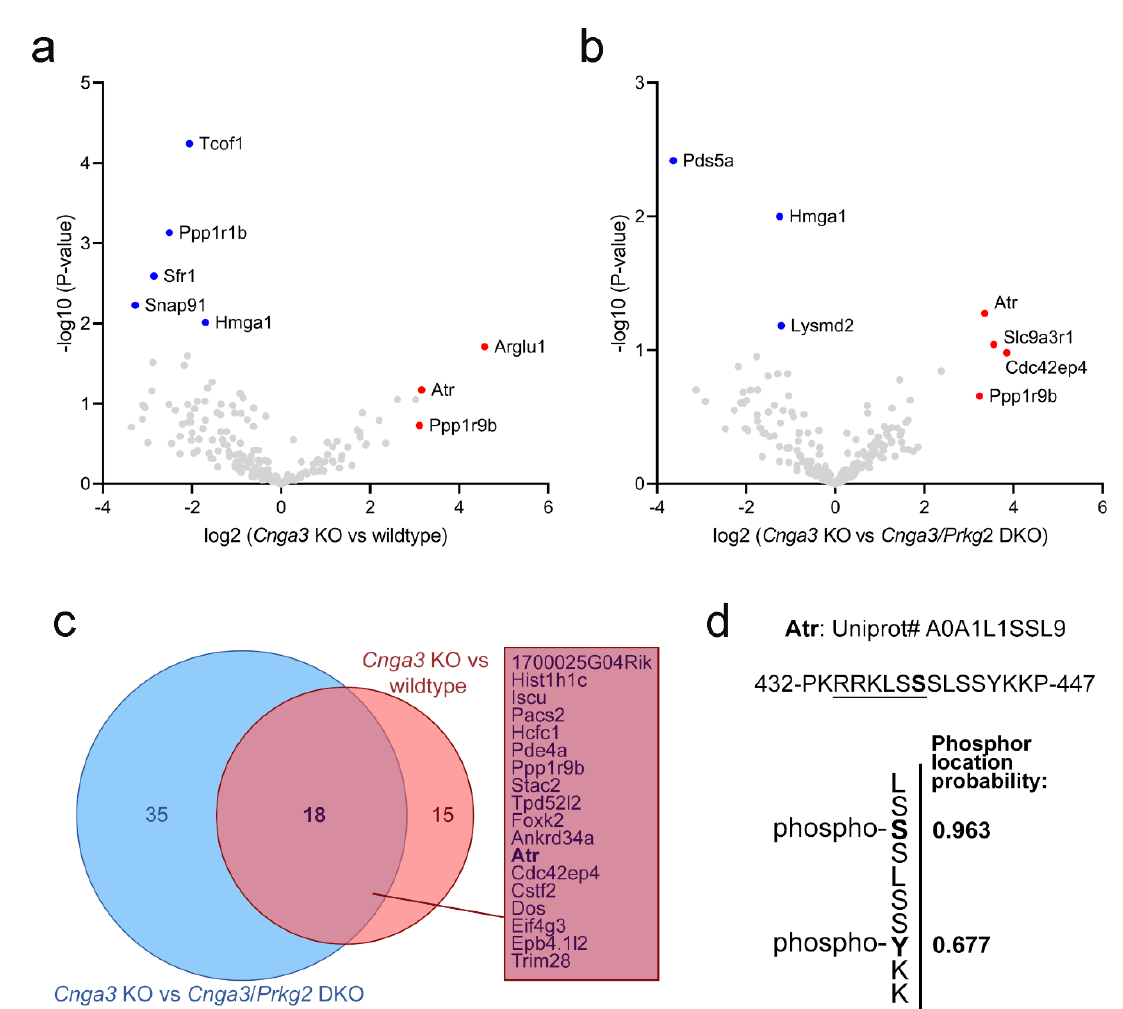
Figure 4. Mass spectrometry-based analysis of Ti-IMAC-enriched phosphoproteins in mouse retinal lysates from Cnga3 KO mice. ( a , b ) Volcano plots showing the enrichment/depletion of identified phosphoproteins in Cnga3 KO vs. wildtype ( a ) or versus Cnga3 / Prkg2 ( b ) DKO retinal lysates at postnatal week 4 (each dot represents a specific identified phosphorylated peptide). ( c ) Venn diagram showing the number of hits that were enriched in Cnga3 KO over wildtype (blue) or Cnga3 / Prkg2 DKO (red). The 18 hits enriched in both comparisons are listed in the rectangle. ( d ) Sequence of the identified Atr-derived peptide with information on the identified phosphorylation sites (see Supplementary Figure S2 for a representative mass spectrometry (MS) spectrum).